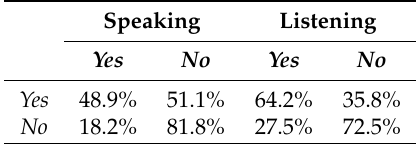
Table 8. Confusion matrices of the proposed nodding prediction models in speaking and listening situations, respectively: the rows are actual classes and the columns are the predicted